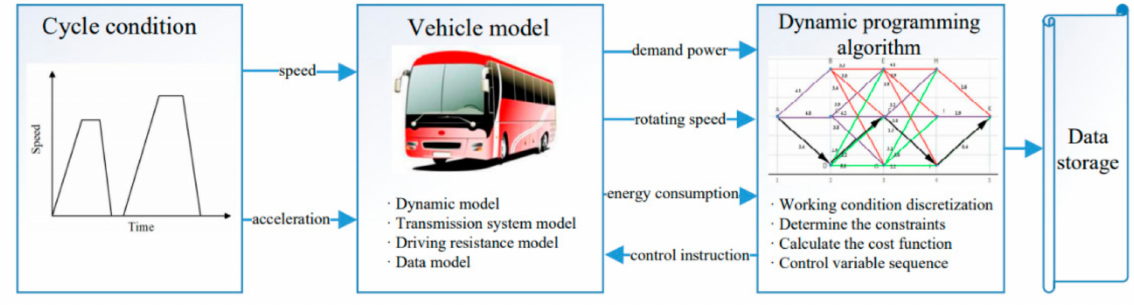
Figure 7. Energy management strategy calculation process based on dynamic programming.